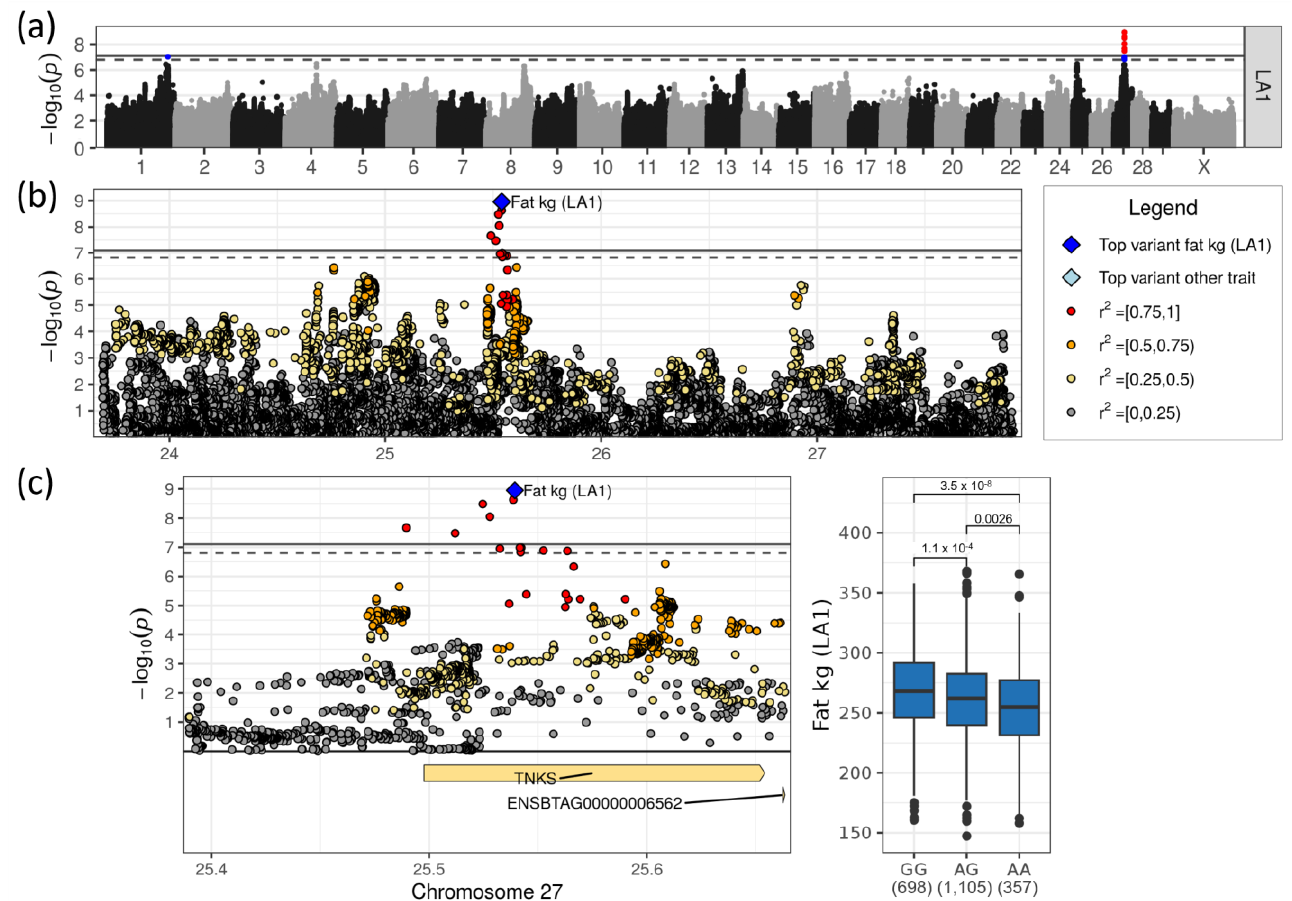
Figure 7. ( a ) Manhattan plot for fat yield in LA1. Suggestive ( p < 0.1, dashed line) and significant ( p < 0.05, solid line) associations were highlighted in blue and red, respectively. ( b ) Regional associa- tion plot for the QTL on chromosome 27. ( c ) Zoomed regional association plot including genes and effect plot for top SNP for fat yield in LA1. Genes containing variant(s) with moderate impact are colored yellow.